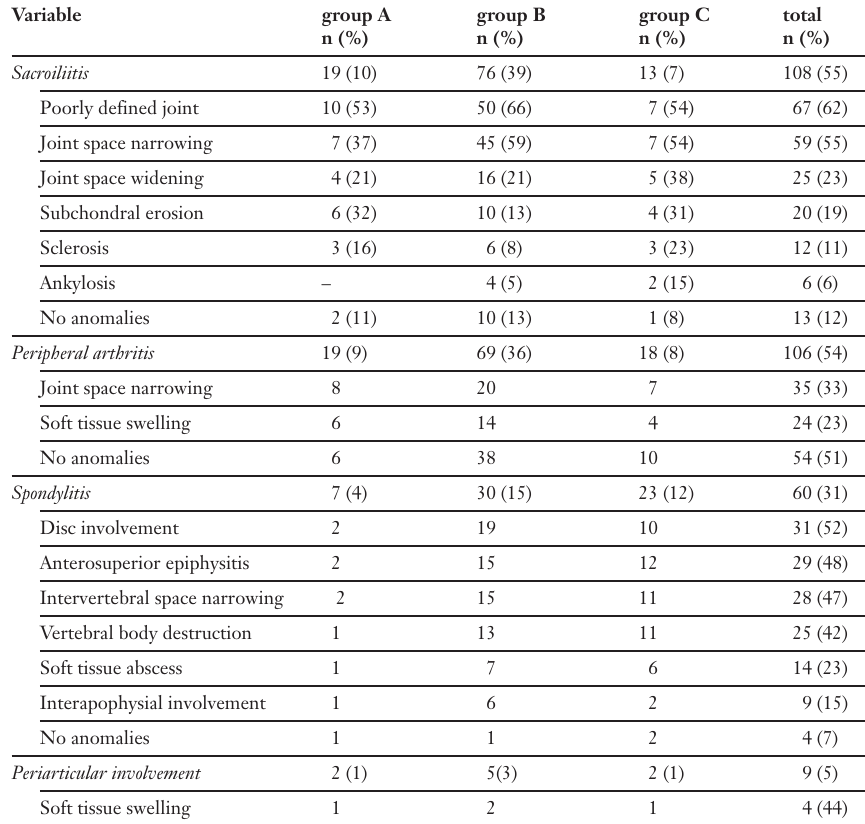
Radiographic ab- normalities in the 195 patients with musculoskeletal